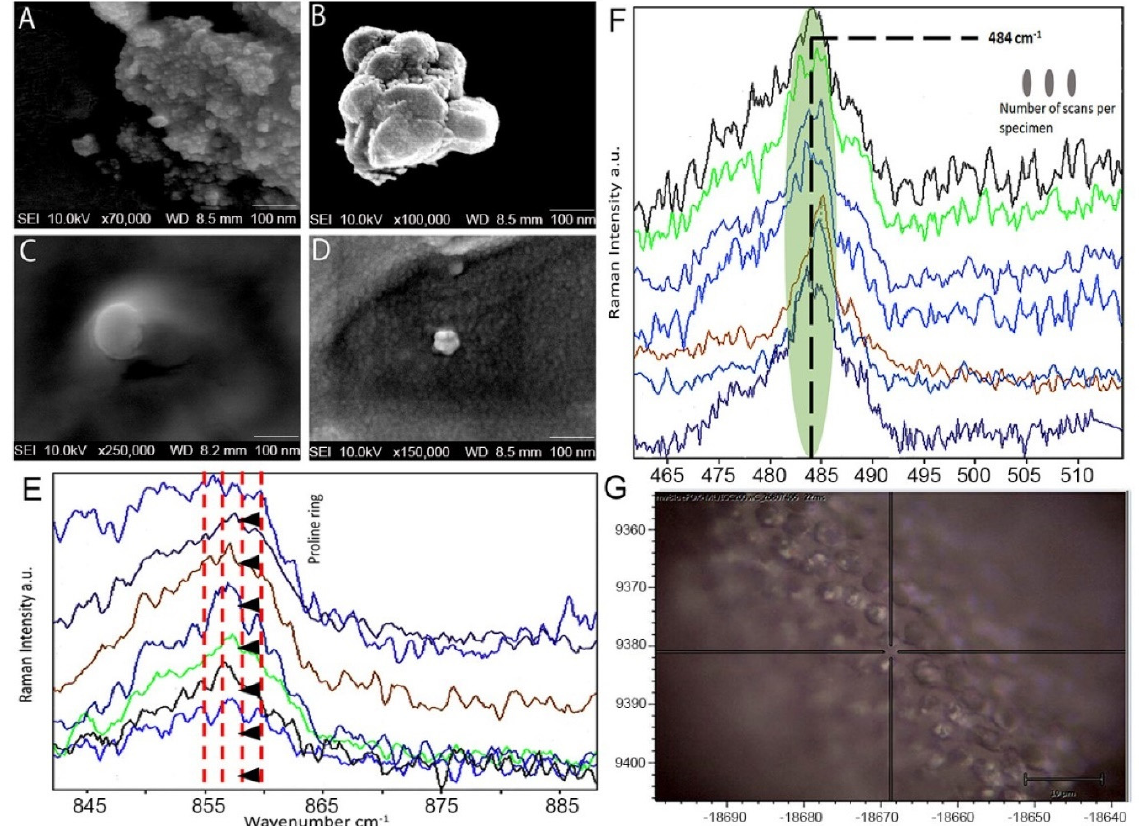
Figure 1 . ( A – D ) The morphology of the developed propolis nanoparticles investigated with the aid of SEM, showing spherical shapes and agglomerations. ( E ) Representative Raman spectra recorded in the region of different experimental specimens where there is a proline bond at 855 cm − 1 and ( F ) 484 cm − 1 regions; ( G ) a representative spectral region drawn for Raman peaks.